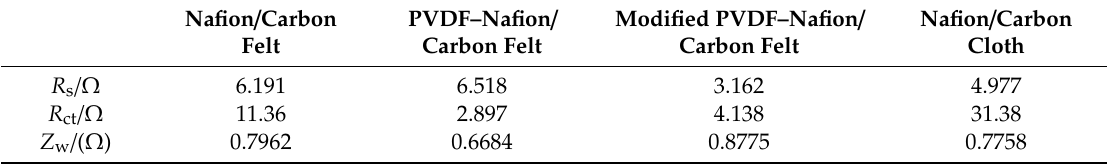
Table 3. Impedance data obtained by equivalent circuit fitting.